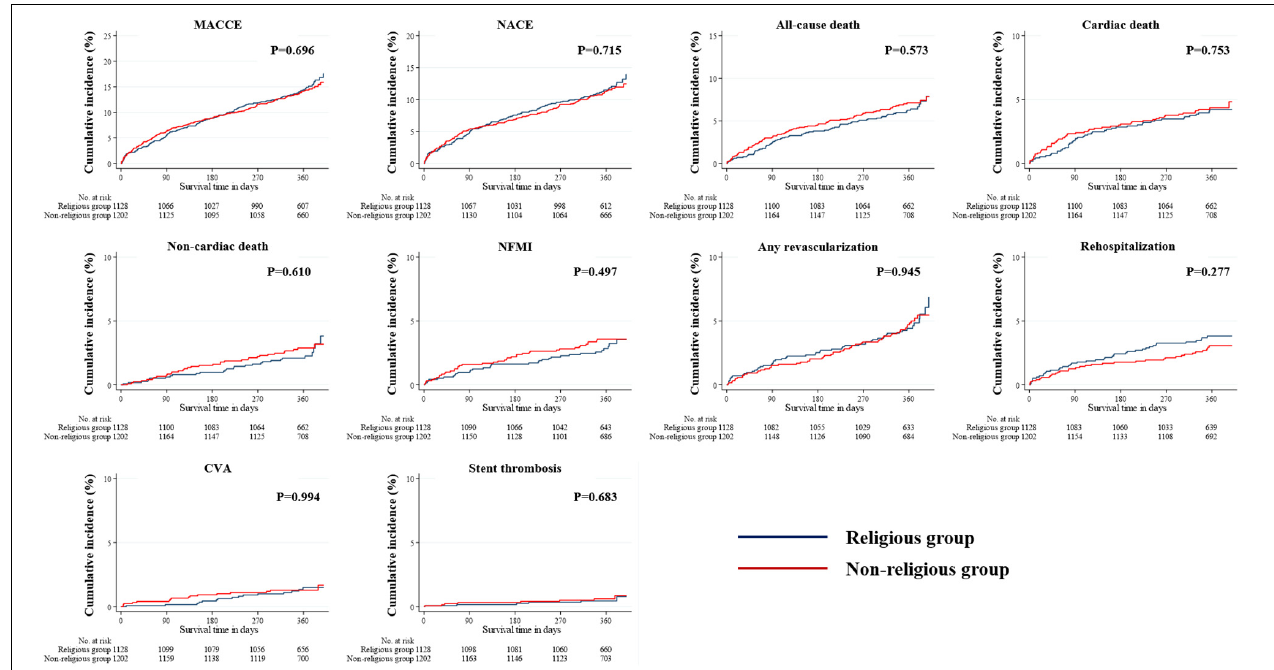
FIGURE 3 | Incidences of primary and secondary clinical outcomes in all patients after a 1-year follow-up (before PSM- or IPTW-adjusted analysis). The figure shows the Kaplan–Meier curves for cumulative event rates according to the presence or absence of religious faith. IPTW, inverse probability of treatment weighting; PSM, propensity score matching.